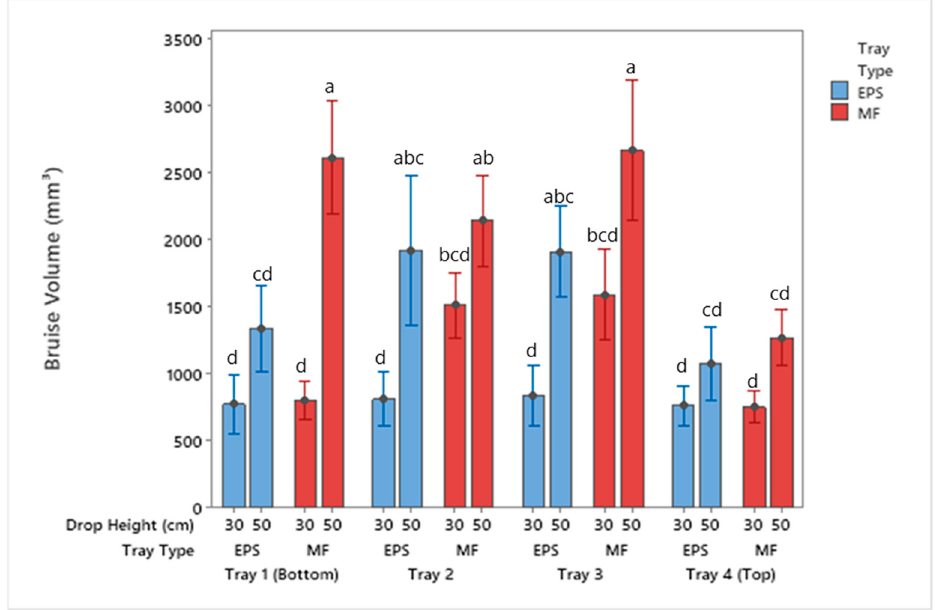
Figure 5. Bruise volume of apples by tray location packaged using MF and EPS trays from 30 and 50 cm drop height (mean ± SD, n = 2). Different letters indicate statistically significant differences at p < 0.05. Bars with no common letters are significantly different ( p < 0.05).